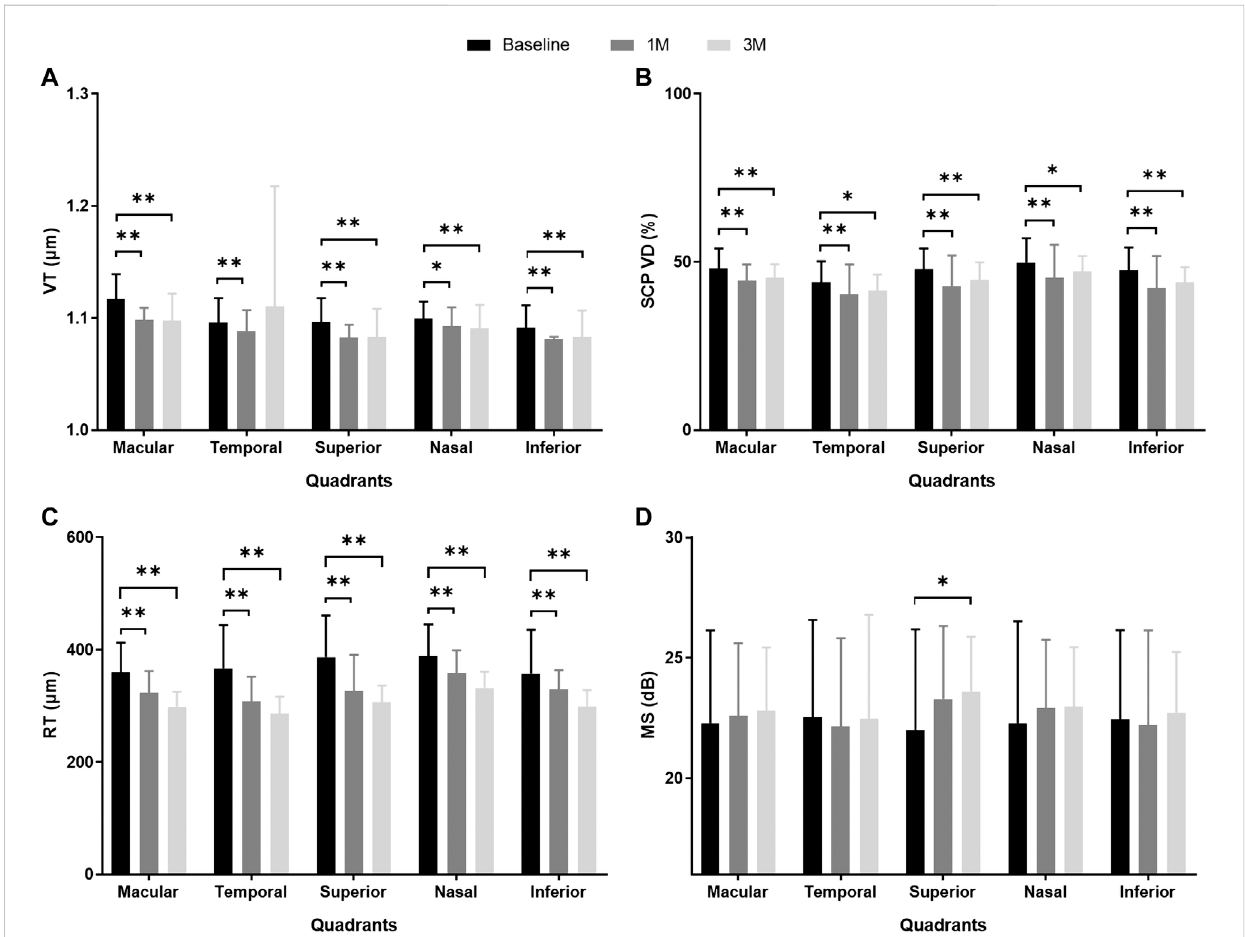
FIGURE 2 MS and anatomical parameters of the macular region in eyes with iERM observed at baseline and 1 month (1M) and 3 months (3M) after vitreoretinal surgery. (A) VT; (B) SCP VD (%); (C) RT ( μ m); (D) MS (dB). ** p < 0.01, * p < 0.05. Abbreviations: iERM, idiopathic epiretinal membrane; VT, vessel tortuosity; SCP, super fi cial capillary plexus; VD, vessel density; RT, retinal thickness; MS, mean